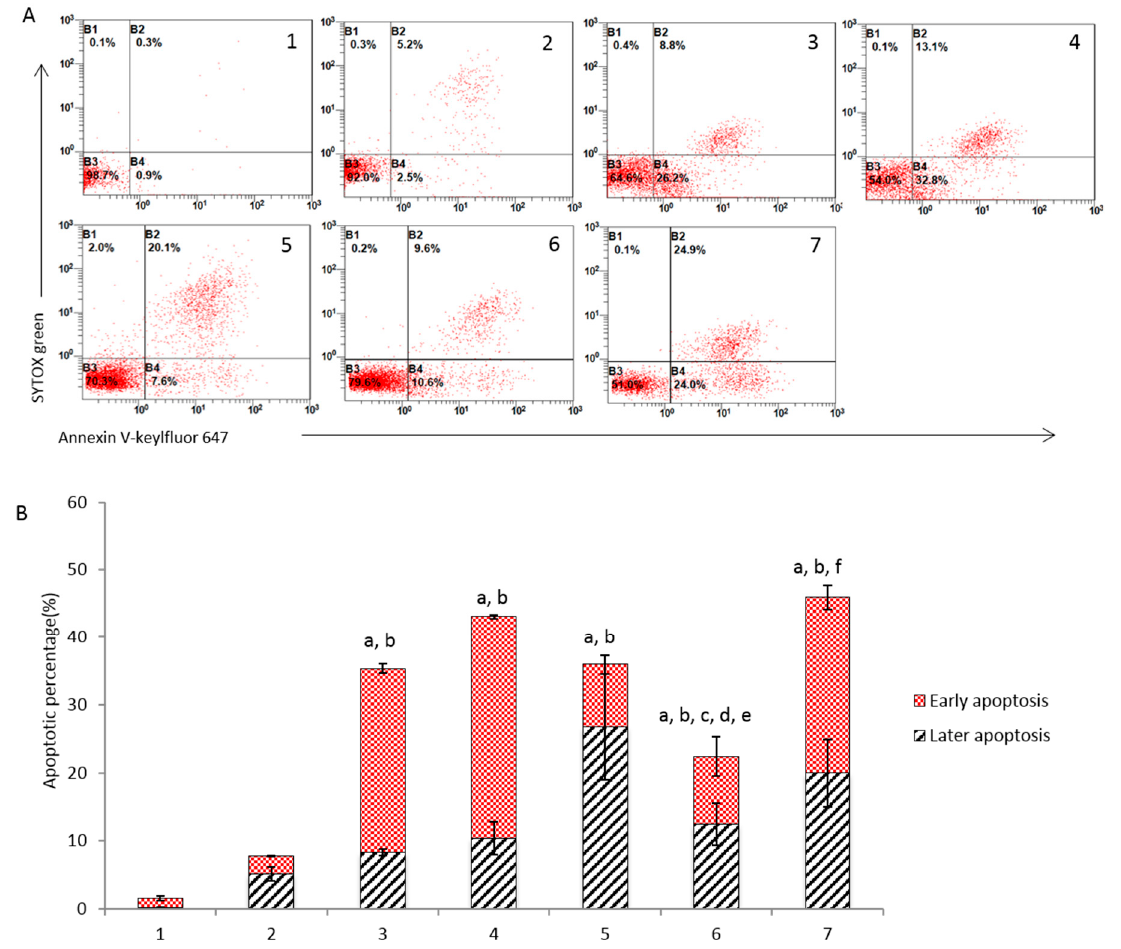
Figure 3. Apoptosis induced in breast cancer MDA-MB-435S cells. ( A ) Flow cytometry plot of breast cancer cells after treatment with varying formulations; ( B ) apoptotic percentage in breast cancer cells after the treatment. 1, blank control; 2, free dihydroartemisinin; 3, free epirubicin; 4, free dihydroartemisinin plus epirubicin (mole ratio = 2:1); 5, dihydroartemisinin liposomes; 6, epirubicin liposomes; 7, dihydroartemisinin plus epirubicin liposomes. Data are presented as the mean